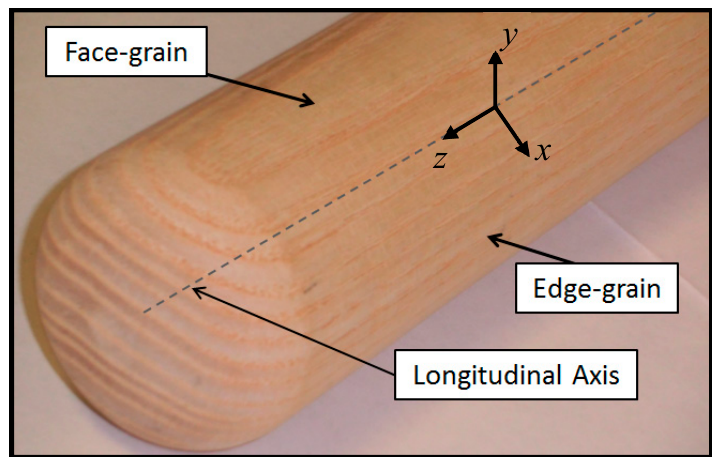
Figure 2. Face-grain and edge-grain surfaces of an ash wood baseball bat.